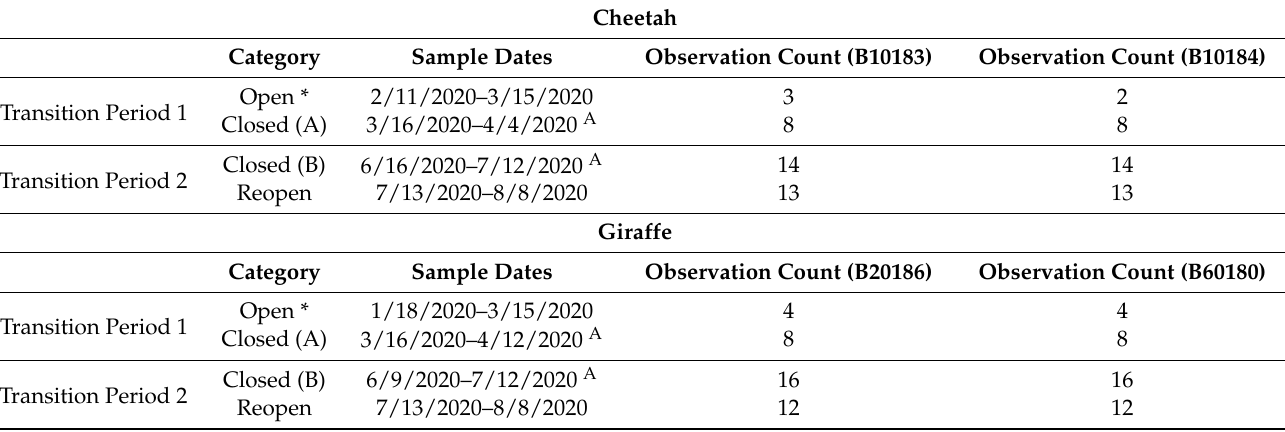
Table 4. List of treatments and their corresponding dates and observation counts. Uneven observation counts are due to restrictions from COVID-19 safety protocols. Asterisks (*) indicate observations from general monitoring (60 min observations instead of 20 min observations) and conducted by volunteers. A : indicates variable observation dates due to the lack of exhibit access because of routine habitat